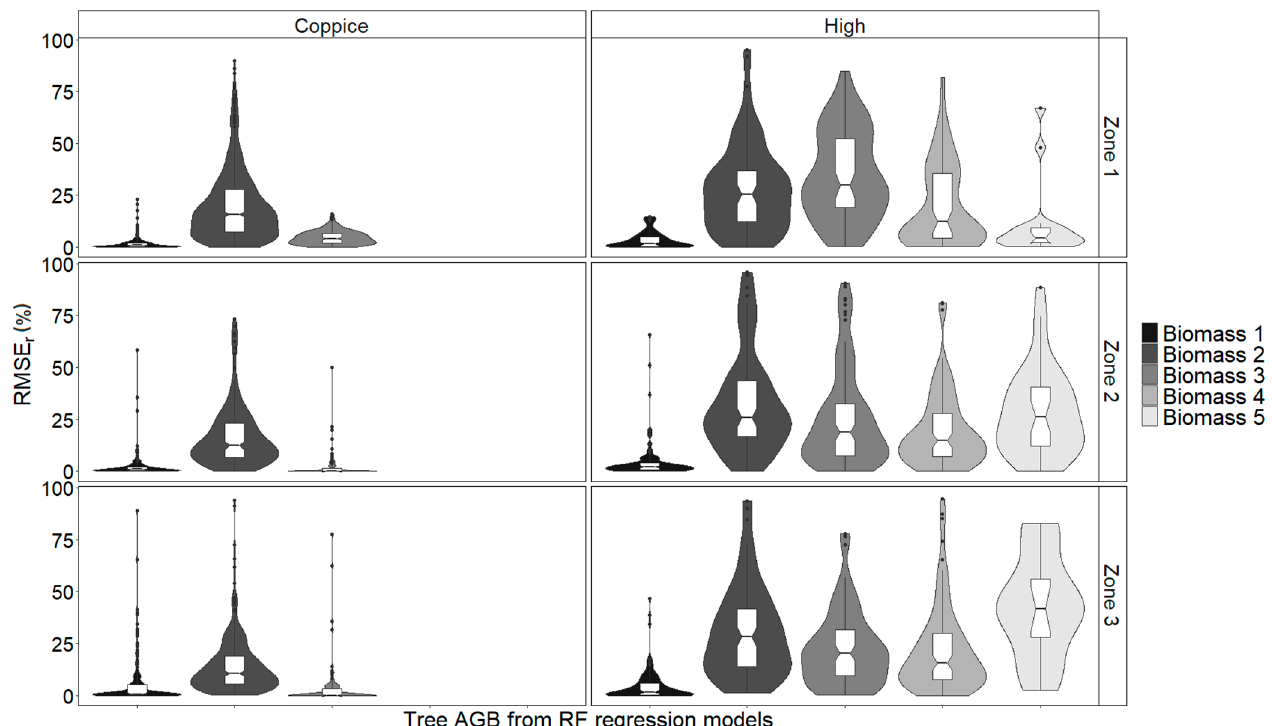
Figure 7. Relative RSME values of RFR models for AGB estimation.